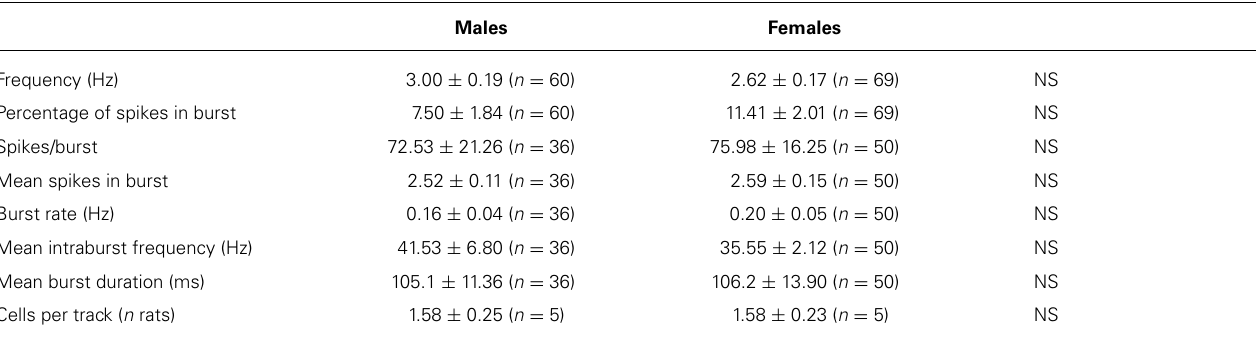
Table 1 | Electrophysiological properties ofVTA dopamine neurons recorded from male and female LH rats in vivo